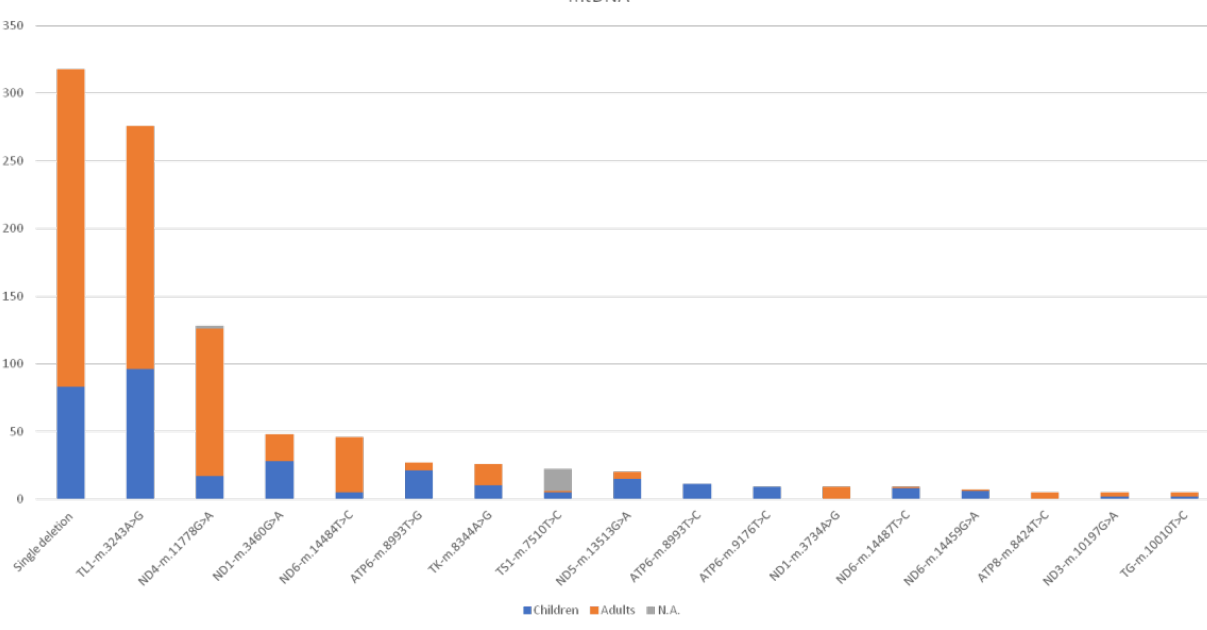
Figure 3. Number of reported cases for mtDNA mutations distributed by age. Only genes with more than four cases are depicted. The rest of mutated genes and number of patients reported are detailed in Supplementary Table S2. Abbreviations: N.A., not available.